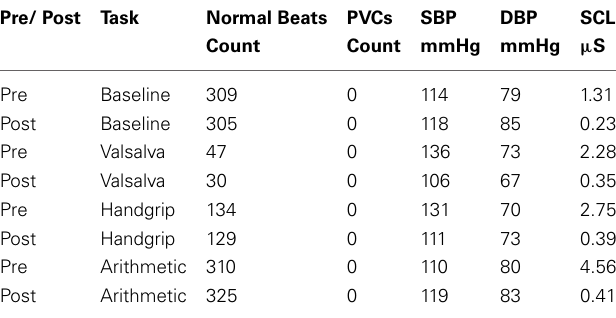
Table 4 | Mean measures of systolic blood pressure (SBP), diastolic blood pressure (DBP) and skin conductance level (SCL) during baseline, valsalva maneuver, isometric handgrip and mental arithmetic stressor, before and after BCSD in Case